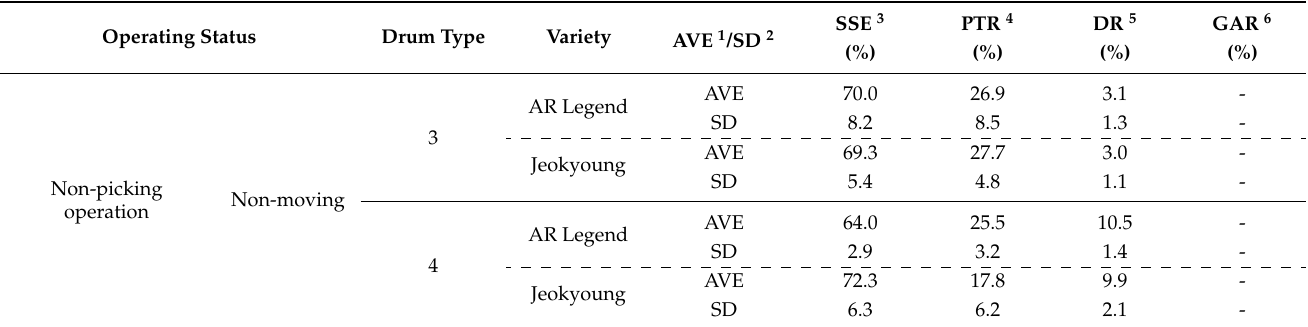
Table 5. Experiment results of field test based on moving operation of drum type and variety of pepper used for each picking part